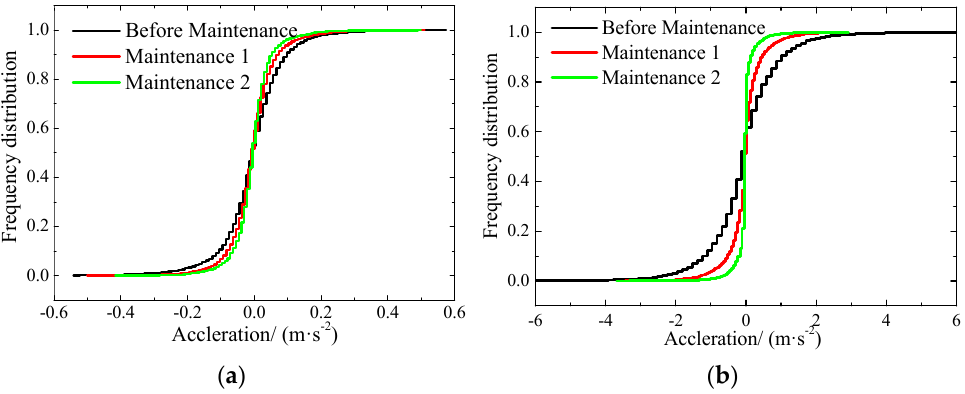
Figure 14. The effect of the maintenance suggestions (on vibration): ( a ) vertical vibration; ( b ) lat- Figure 14. Theeffectofthemaintenancesuggestions(onvibration): ( a )verticalvibration; ( b )lateralvibration. eral vibration. Table 3. Statistical values of the acceleration of pantograph strip.